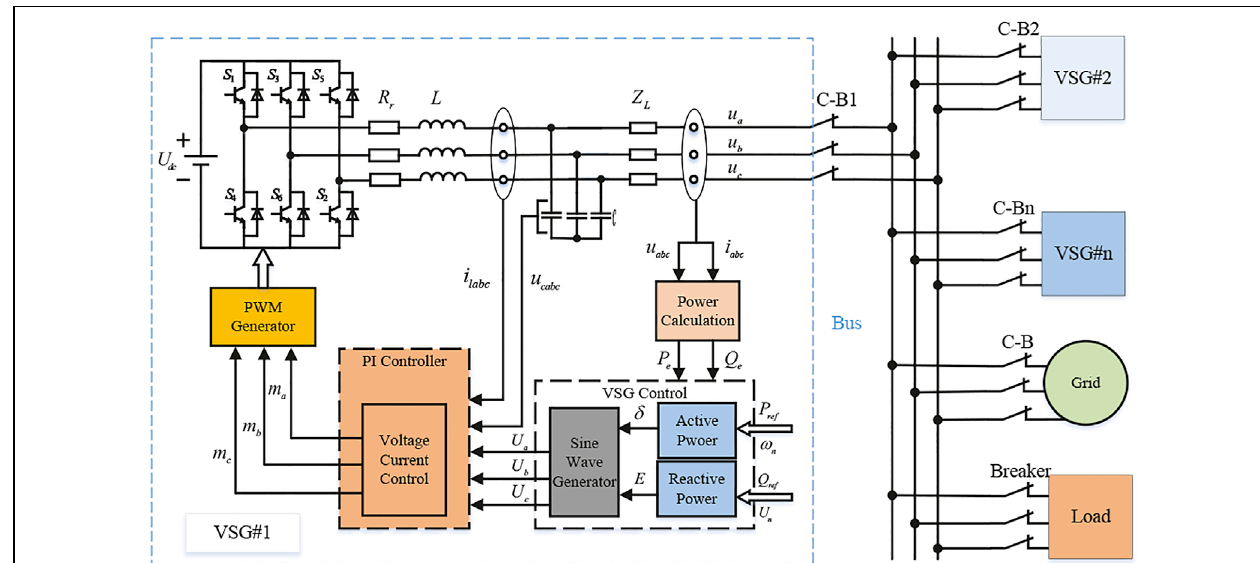
FIGURE 1 | Classic topology and control block of